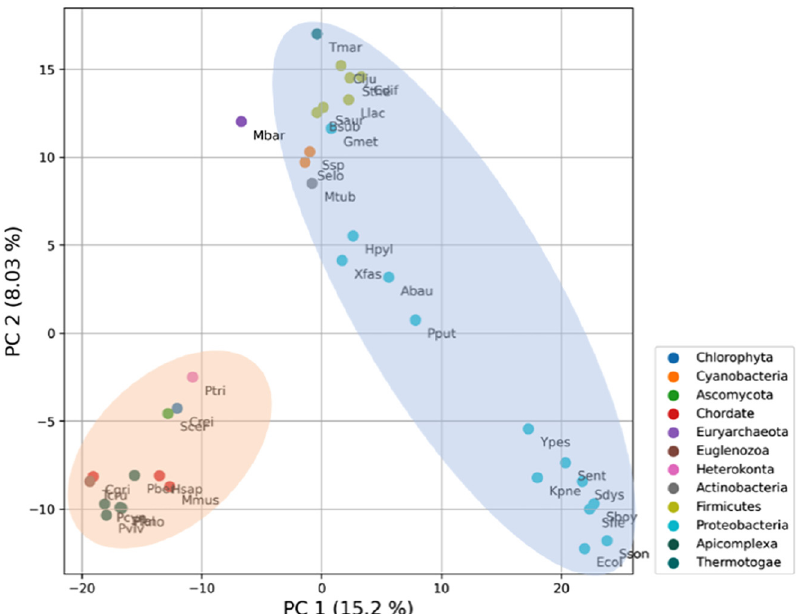
Figure 3: PCA plot of the COG-annotated metabolic functions obtained for all organisms present in BiGG database and for S. thermophilus and X. fastidiosa . The plot illustrates the contribution of principal components (PC) 1 and 2 to the variability of metabolic functions, including the percentage of explained variance. PCA scores are plotted, and the dots were coloured according to the organism’s phylum. The set of models for each organism is surrounded by ellipses that are only used for illustration purposes and do not represent real clusters. Eukaryotes and bacteria are represented by orange and blue ellipses, respectively, while the dot outside belongs to Archaea. An identifier for each organism was also used to annotate each dot, consisting of the first letter of the genus and the first three letters of the species’ second name.